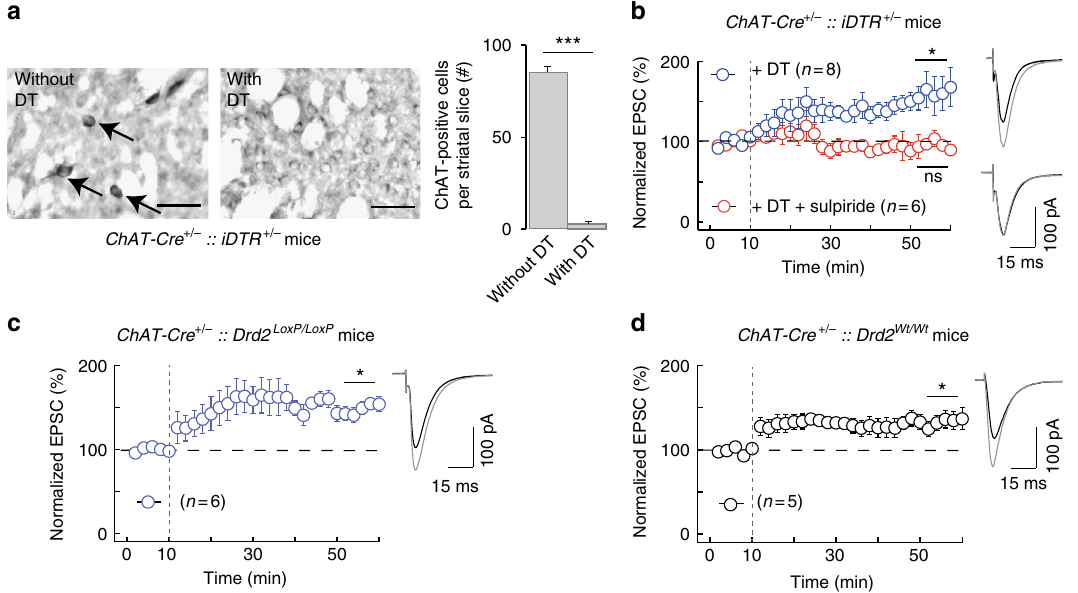
Fig. 5 eCB-tLTP does not depend on D 2 R expressed by cholinergic interneurons. a , b Experiments of plasticity expression in genetically-ablated mice for ChAT-expressing neurons in the dorsal striatum. a ChAT immunostaining in ChAT-Cre + / − ::iDTR + / − (left panels) mice injected with DT stereotaxically in the dorsal striatum (right hemisphere) and without DT injection (left hemisphere); quanti fi cation (right bar graph) of the number of Ach-positive cells per striatal slices ( n = 6 mice). b tLTP was induced with 15 post-pre pairings in ChAT-Cre + / − ::iDTR + / − mice ( n = 8, 8/8 cells showed tLTP) injected bilaterally with diphtheria toxin in the dorsal striatum. tLTP observed in cholinergic interneuron-ablated mice was D 2 R-mediated because it was prevented by sulpiride (10 µ M, n = 6, 2/6 cells showed tLTP). c , d STDP expression in selective cKO for D 2 R expressed by cholinergic interneurons. c In mice in which D 2 R was speci fi cally knocked-out in cholinergic interneurons ( ChAT-Cre + / − ::Drd2 LoxP/LoxP mice) tLTP was induced with 15 post-pre pairings ( n = 6, 6/6 cells showed tLTP). d tLTP was observed in mice serving as the Cre driver control ( ChAT-Cre + / − ::Drd2 Wt/Wt mice, n = 5; 4/5 cells showed tLTP). Representative traces are the average of 15 EPSCs during baseline (black traces) and 45min after STDP protocol (grey traces). Vertical grey dashed line indicates the STDP protocol. Error bars represent sem. * p < 0.05; *** p < 0.001; ns: not signi fi cant by Wilcoxon Signed rank test ( a ) or one sample t -test ( b – d